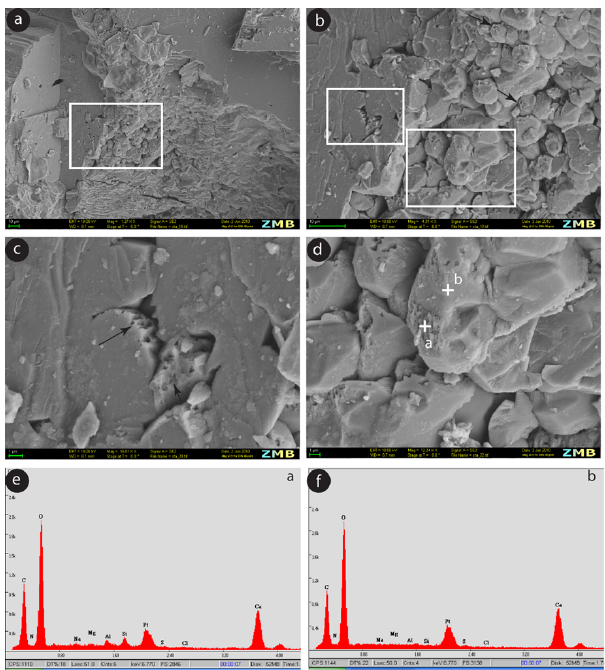
Fig. 5. Secondary electron images of the surface of the stalactite: (a–c) dissolution features (arrows) of the small calcite rhombs close to columnar calcite; (d) they are sometimes covered by a film; (e, f) elemental analyses of this film show that it is composed of alumi- nosilicates on the top of calcite rhombs.